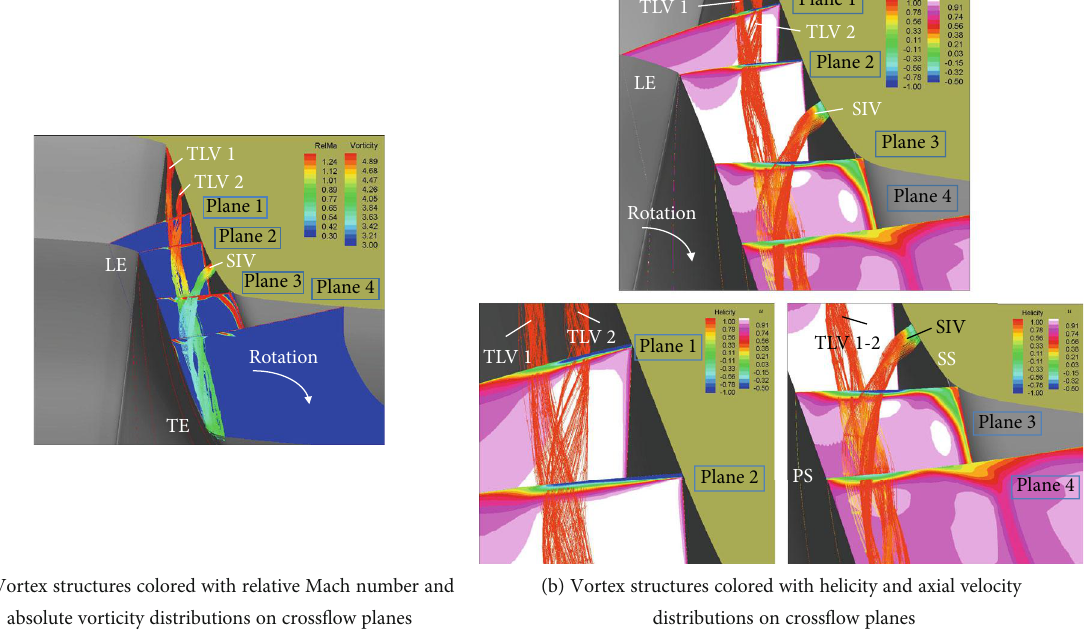
Figure 18: Characteristics of shock-induced vortex stability at near-peak e ffi ciency condition for Rotor 67.